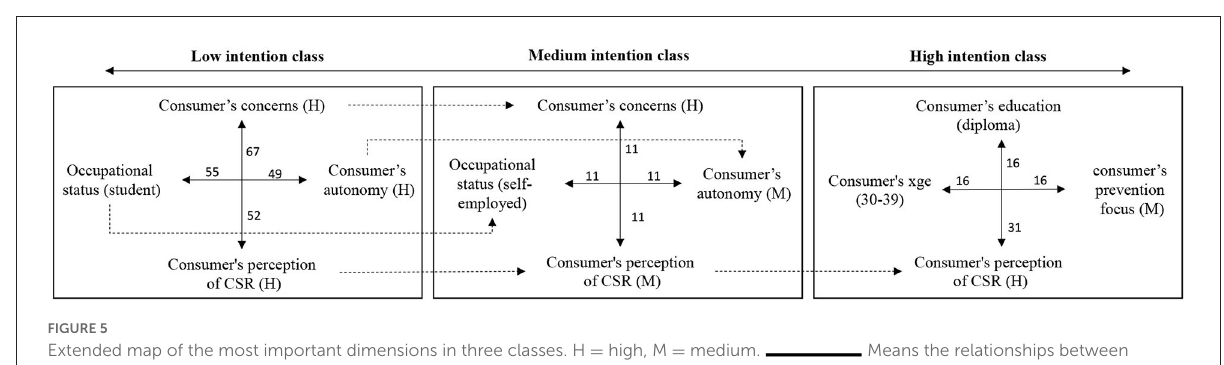
FIGURE5 Extended map of the most important dimensions in three classes. H = high, M = medium. Means the relationships between variables in each class. Means the relationships between the variables in different